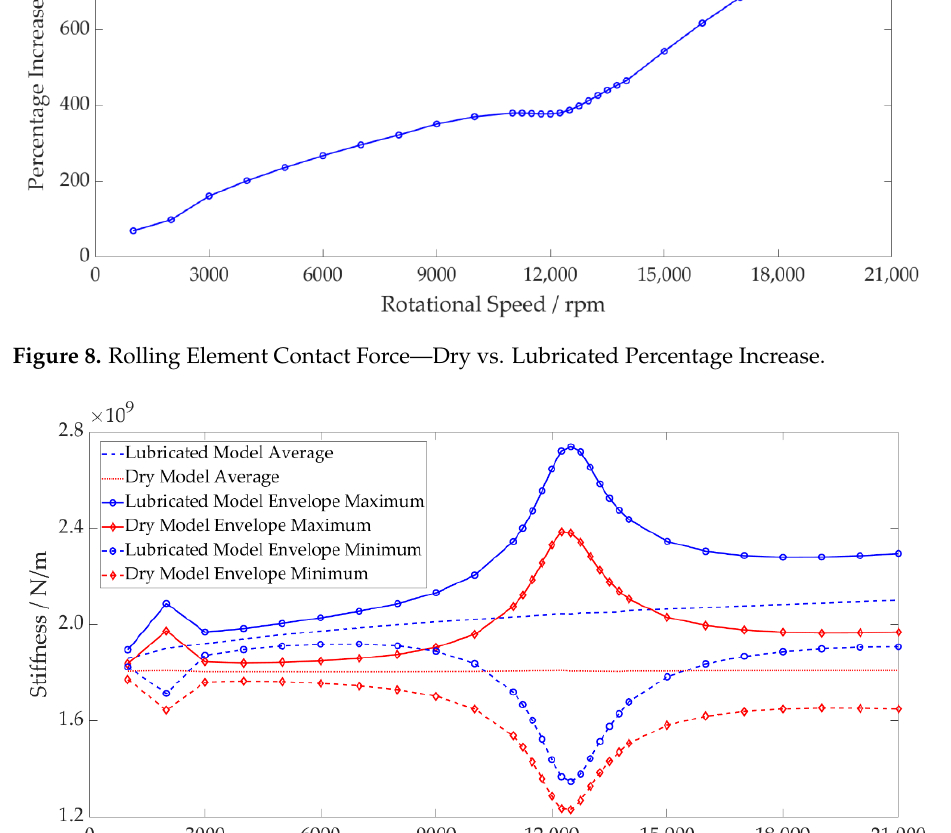
Figure 8. Rolling Element Contact Force — Dry vs. Lubricated Percentage Increase.